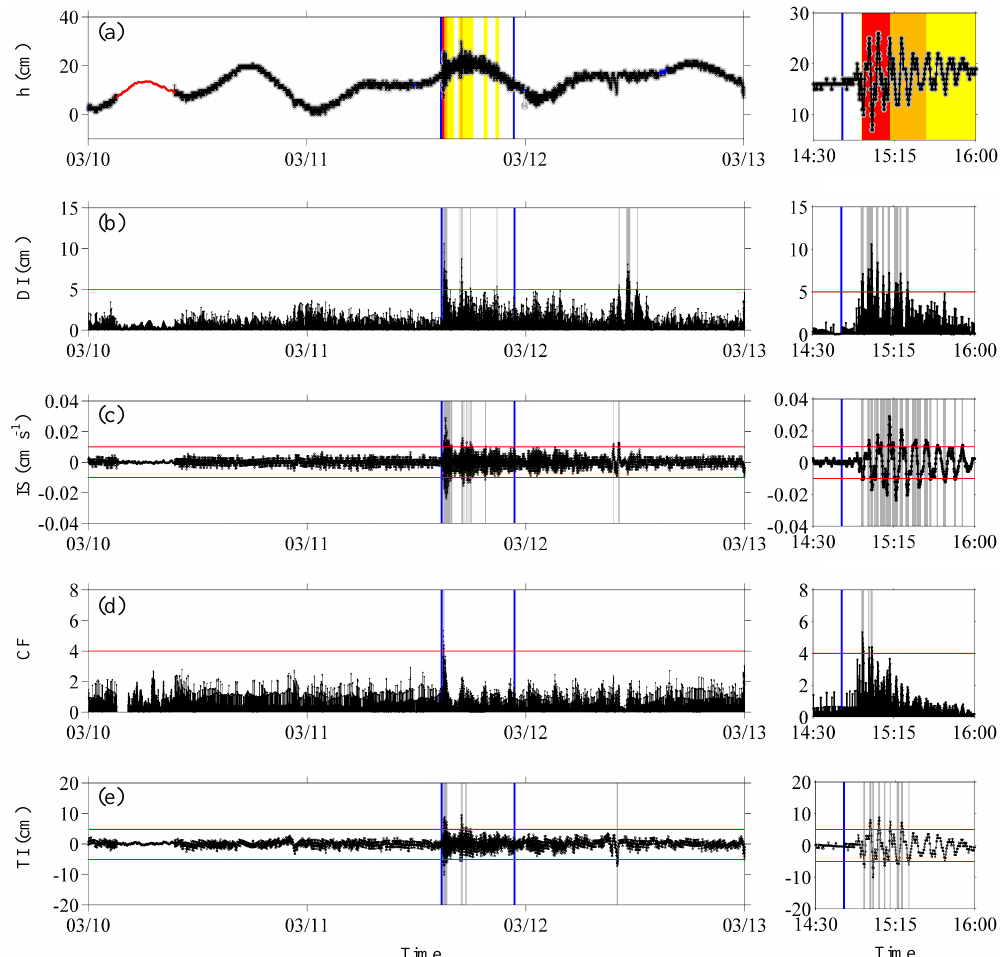
Figure 11. Performance test of TADS for the case of the 2011 T¯ohoku tsunami. Blue vertical lines show the event period from 11 March 14:46LT to 11 March 22:46LT. For clarity, the records near the tsunami arrival time are zoomed in on the right side. (a) Time series of the Ulleung-do surge gauge after applying the TADS (black line) where outliers are marked by a gray line and gap-filled data are marked by a blue line (SGFA) and red line (LGFA). Vertical lines represent the alarm: warning (red), advisory (orange), and watch (yellow). Four indices of the tsunami detection algorithm are given: (b) DI, (c) IS, (d) CF, and (e) TI. Red horizontal lines represent the thresholds and gray vertical lines mark the time whenever thresholds are triggered.